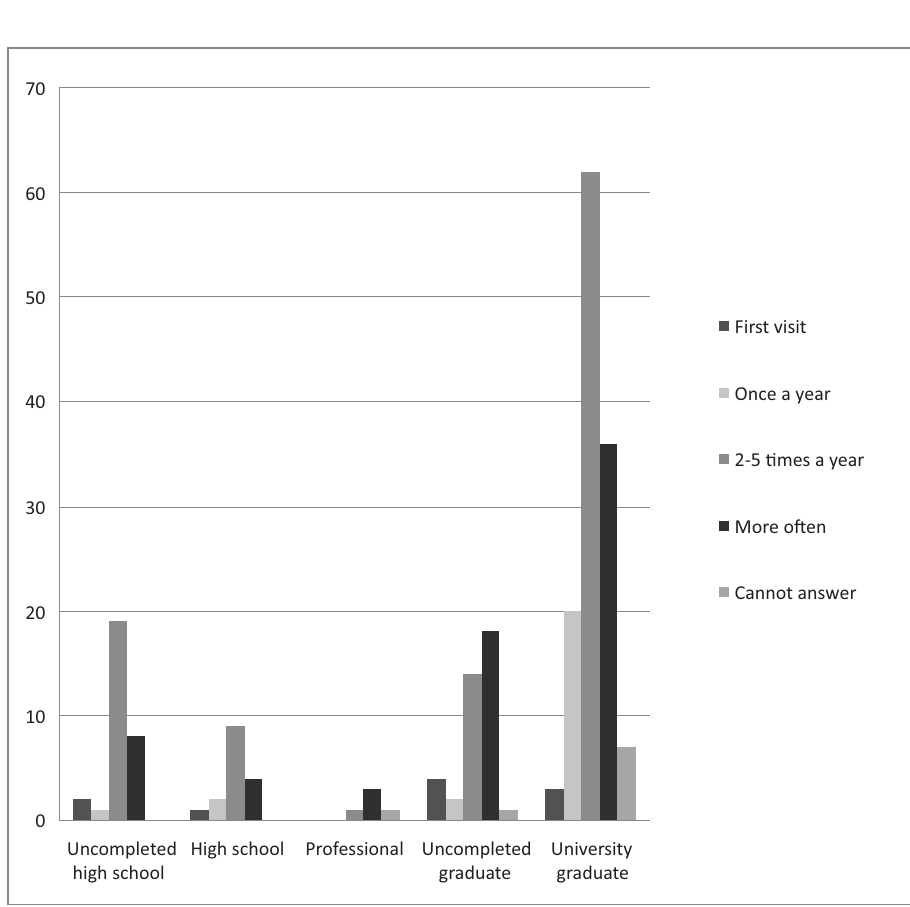
Fig. 9. Correlation between Vilnius festival visits and gender